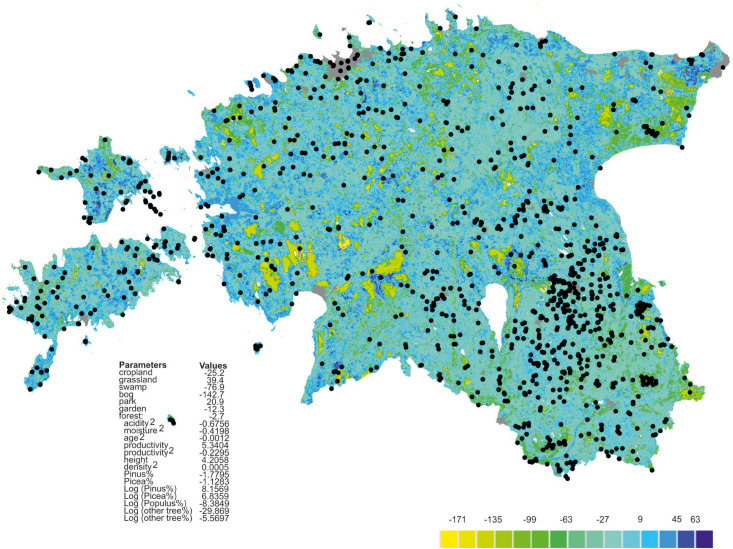
Extrapolated fungal richness map of Estonia. Colors represent relative richness of fungi accounting for land use type and estimated soil litho-genetical scalar (acidity), estimated soil moisture scalar (humidity) and vegetation data as based on the best GLM model. Gray represents towns, roads and buildings; black circles represent plots.